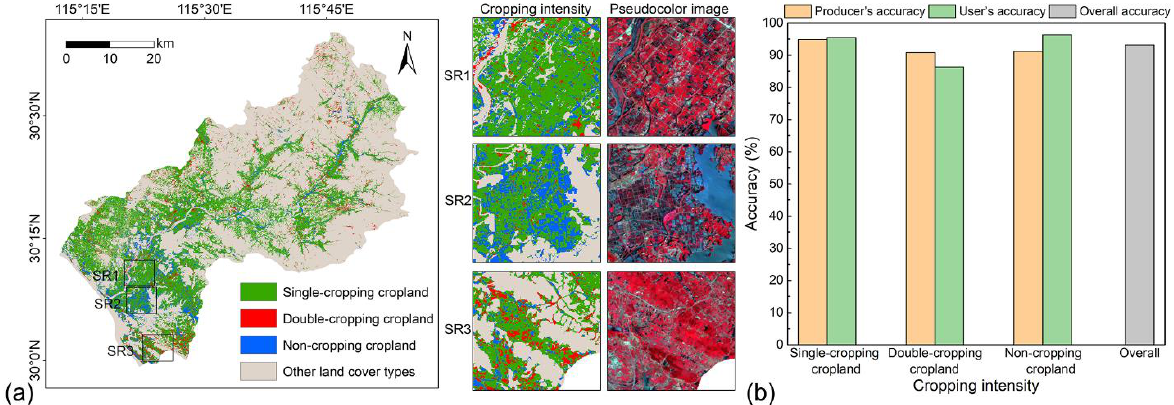
Figure 6. ( a ) Cropping intensity map of the study area with 3 sub-regions (SRs) for details. The corresponding HLS S30 pseudo-color images (RGB: near-infrared (B8A), red (B4), green (B3)) on June 4, 2019, over 3 SRs were also displayed. ( b ) Accuracy of the cropping intensity map evaluated by crop field samples.